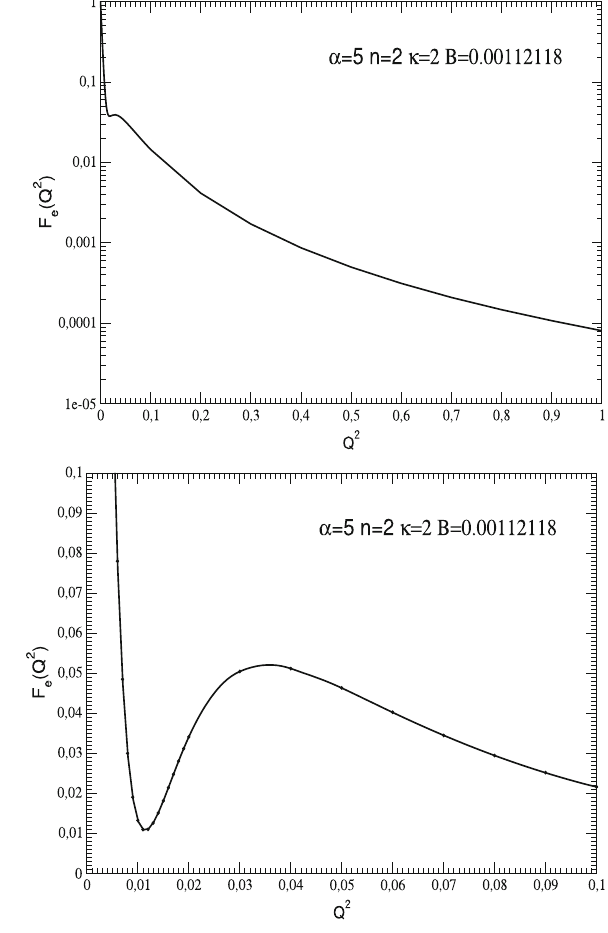
Fig. 15 Elastic form factor of the abnormal state No. 4 of Table 1 ( n = 2, κ = 2). The non-trivial structure at Q 2 ≈ 0 . 01 is detailed in the lower